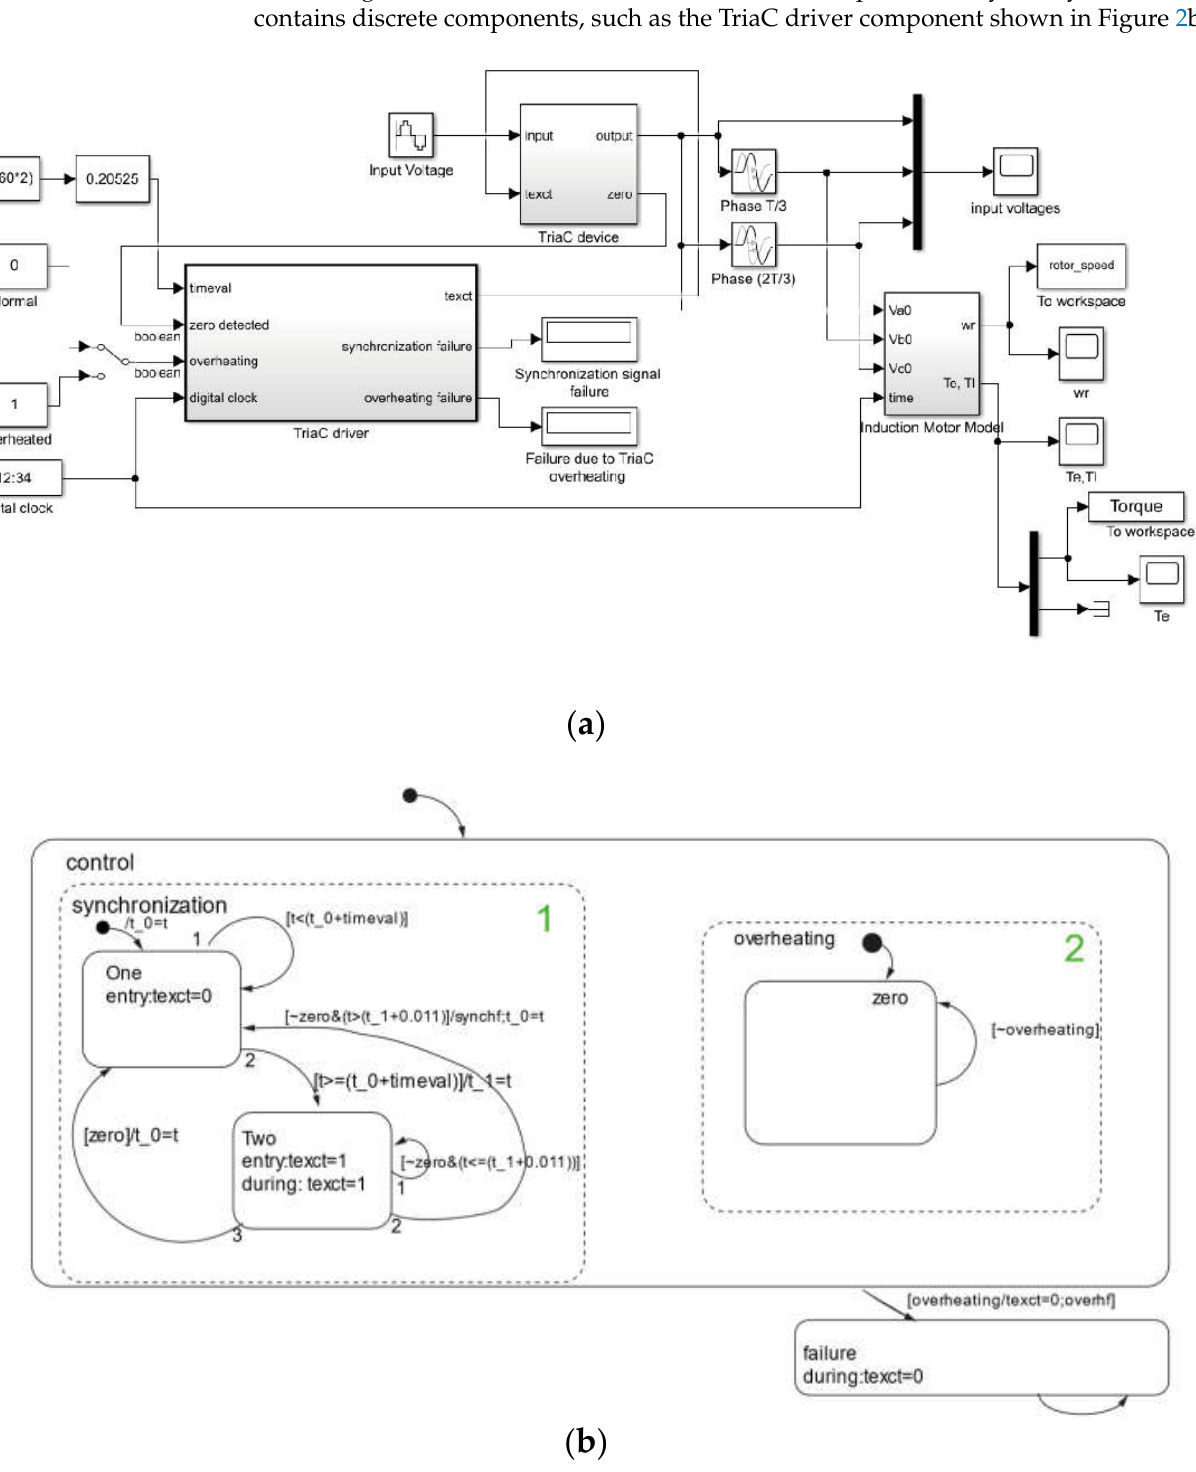
Figure 1. ( a ) System context diagram. ( b ) Graphical plot of the input voltage and the excitation signal of the TriaC device.